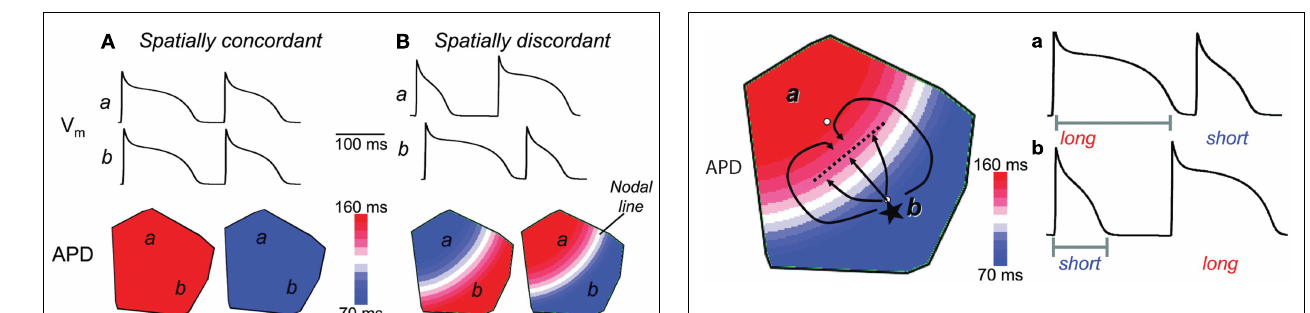
FIGURE 5 | Spatially discordant alternans predisposes premature excitations to induce conduction block and reentry. One mechanism by which SDA predisposes otherwise benign premature beats to conduction block and reentry is diagrammed. An ectopic beat (asterisk) initiated during SDA in the region with a short APD encounters more refractory tissue as it propagates toward the region with long APD. Given a sufficiently steep gradient of refractoriness, conduction block can occur (dashed line). Meanwhile, this beat can successfully propagate laterally, allowing time for recovery of the long APD region and subsequent reentry. Adapted from Weiss et al.